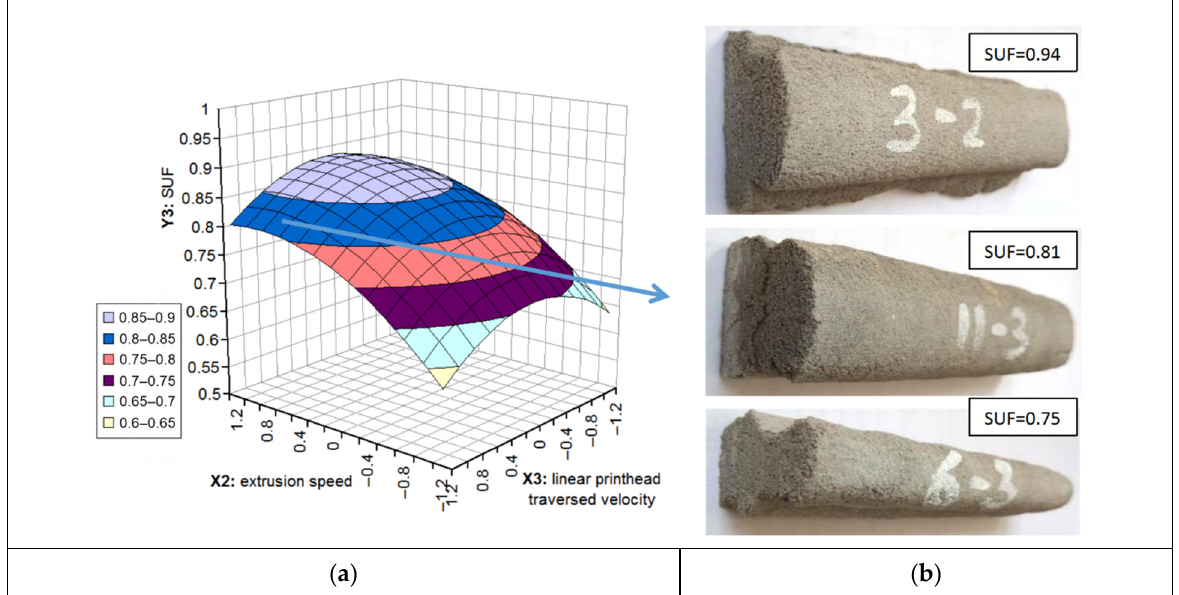
Figure 5. The effect of the screw speed and the linear printhead traversed velocity of the forming device on the utilization factor of the section Y3 (when X1 = 0): ( a ) graphic representation of rela- tionship between screw speed, the linear printhead traversed velocity and utilization factor; ( b ) visual assessment of SUF effect on the samples view. The length of the samples is 150 ± 5 mm.